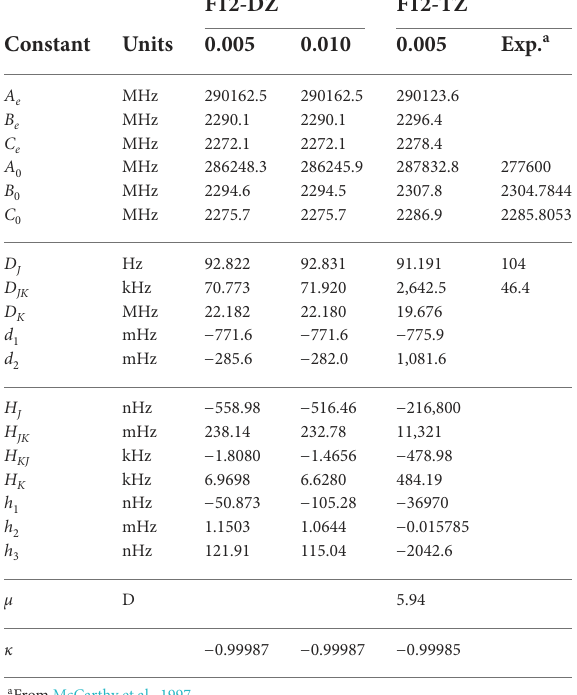
TABLE 2 Rotational constants of l -C 5 H 2 compared to previous experiment a